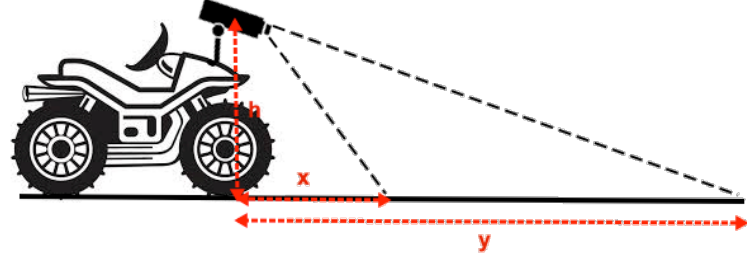
Figure 2. Geometrical properties of the setup for recording.